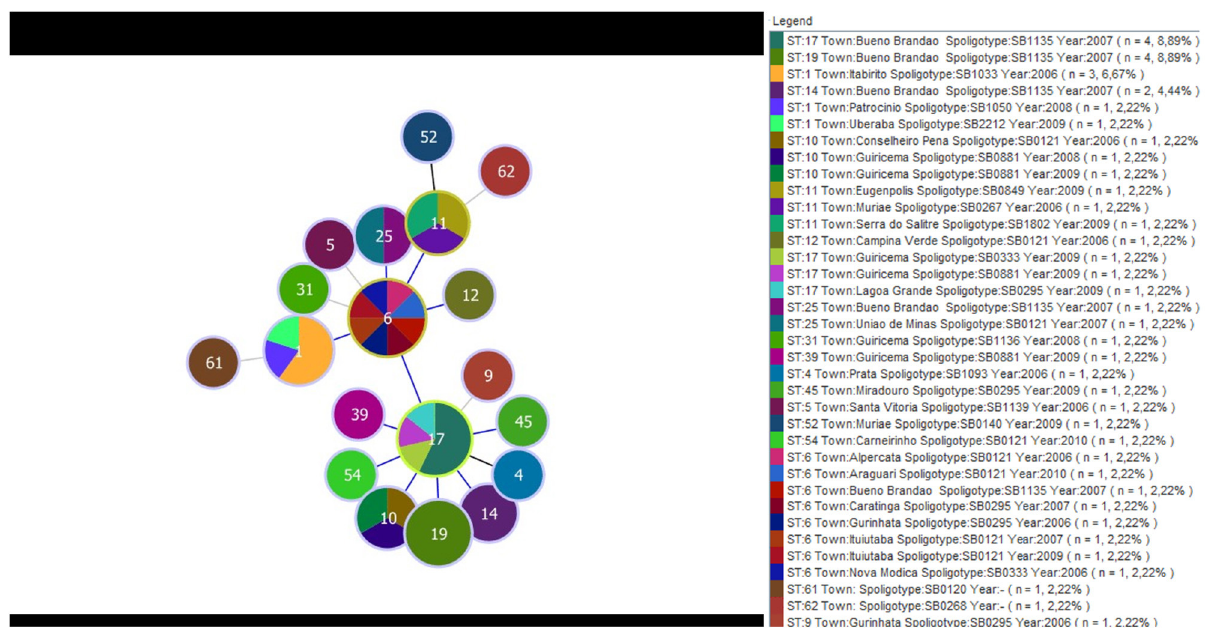
Frontiers in Veterinary Science |